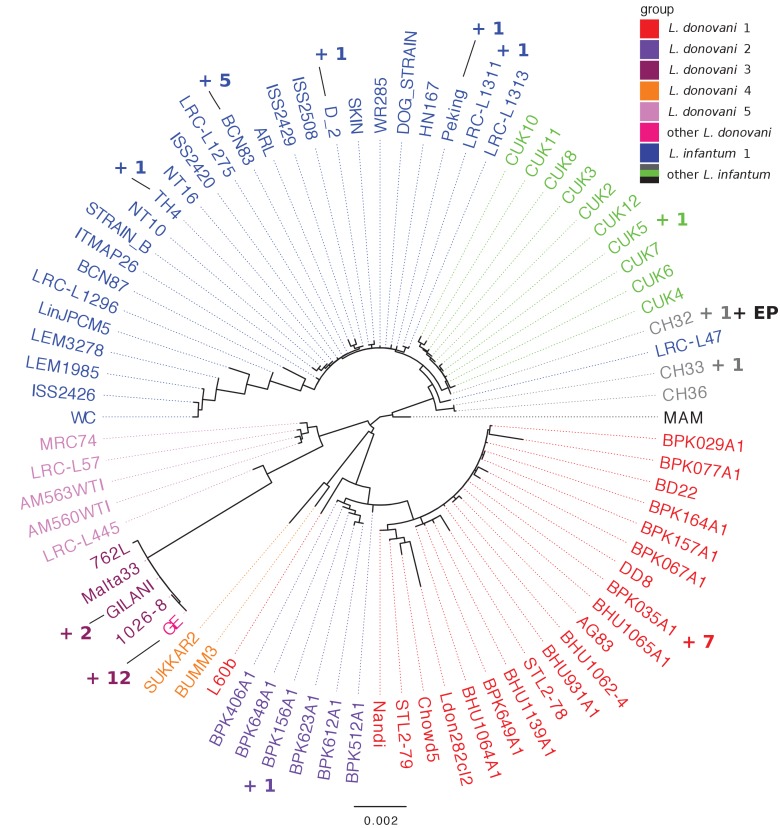
Phylogenetic tree based on the maxicircle DNA.Unrooted tree constructed using RaxML. Only a part of the samples is shown in the tree as the library preparation of some samples removed the kDNA and some samples have identical sequences to the ones shown and were therefore removed for tree estimation. The samples with identical sequences are listed in Supplementary file 3 and the counts of removed samples are indicated near the respective tree leaves. Group identity of each isolate is indicated by the different colours. Phylogenetic reconstruction was repeated with four outgroup isolates of L. mexicana (U1103.v1), L. tropica (P283) and L. amazonensis (two samples). All of those four outgroup-samples were clearly different to the samples of our study (data not shown).